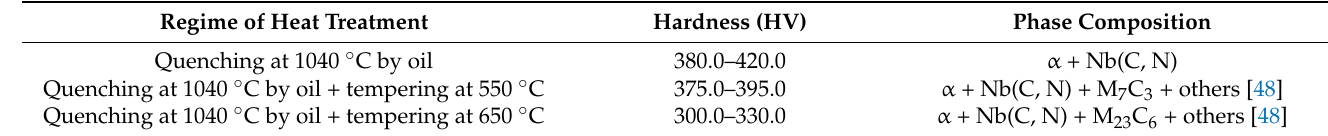
Table 4. Phases of X6CrNiMoVNb11-2 martensitic steel after various heat